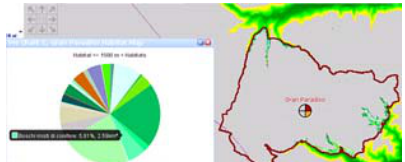
Figure 12. Pie chart for the Gran Paradiso Natural Park Habitats under 1500 m.